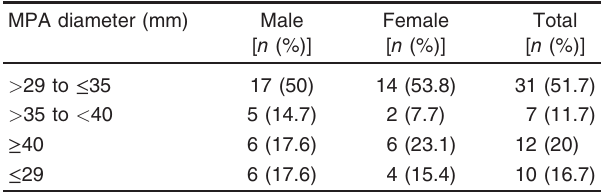
Table 2 Computed tomography measurement of main pulmonary artery diameter in all cases